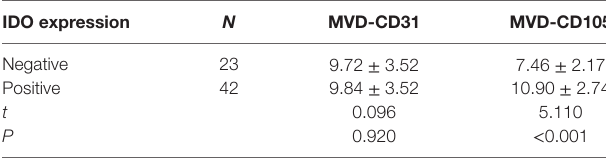
TaBle 1 | Indoleamine 2,3-dioxygenase (IDO) expression associated with microvessel density (MVD) level in tumor microenvironment.